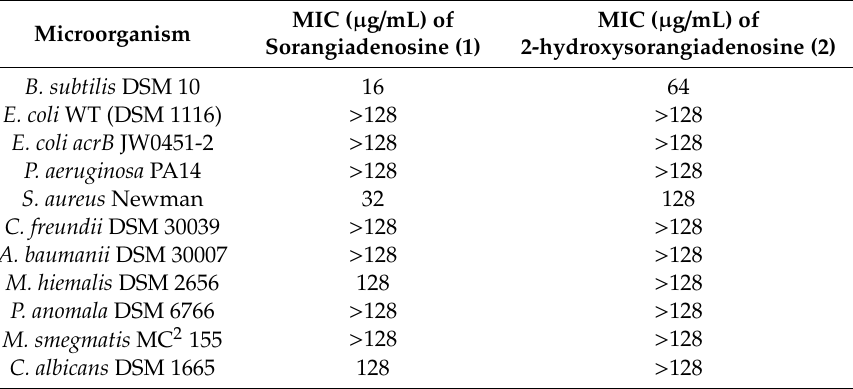
Minimum inhibitory concentration (MIC) values of sorangiadenosine and 2-hydroxysorangiadenosine ( 1 and 2 ) against common microbial pathogens. MIC ( µ g / mL) of Microorganism